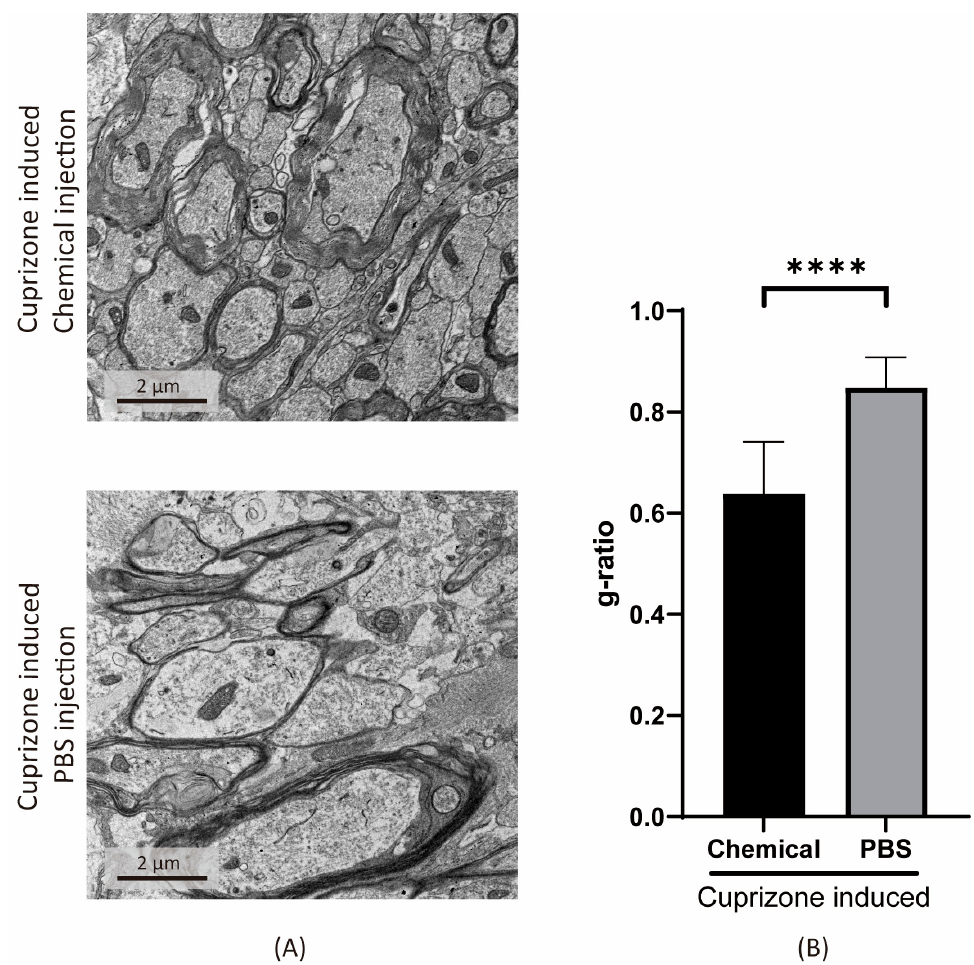
Figure 7. The decrease of g-ratio after chemical cocktail injection into the corpus callosum. B6 mice suffered induced demyelination by consuming a cuprizone diet. The YSF cocktail and PBS were injected directly into the corpus callosum of mice; then, the mice were allowed to recover for two weeks before dissection. Chemical treatment refers to Y27632, SU9516, and forskolin (YSF). ( A ) Elec- tron microscope images of YSF-cocktail- and PBS-injected groups. ( B ) G-ratios are calculated from YSF-cocktail- and PBS-injected groups of mice brain slices. Data are presented as mean ± standard deviation. Significant differences were determined using Student’s t -test, * p < 0.05, ** p < 0.005, *** p < 0.001, **** p < 0.0001.